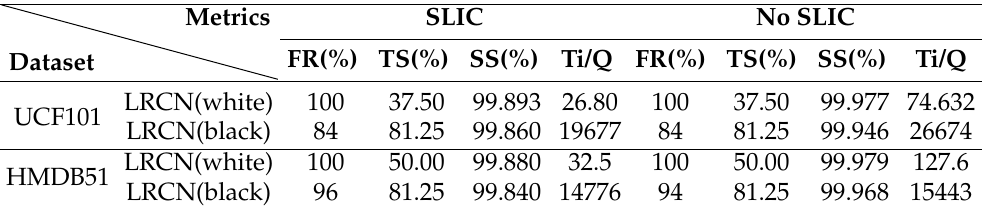
Table 6. Results of the algorithm with SLIC and without SLIC. The “white” in the table means it is tested under the white-box setting and the “black” means it is tested under the black-box